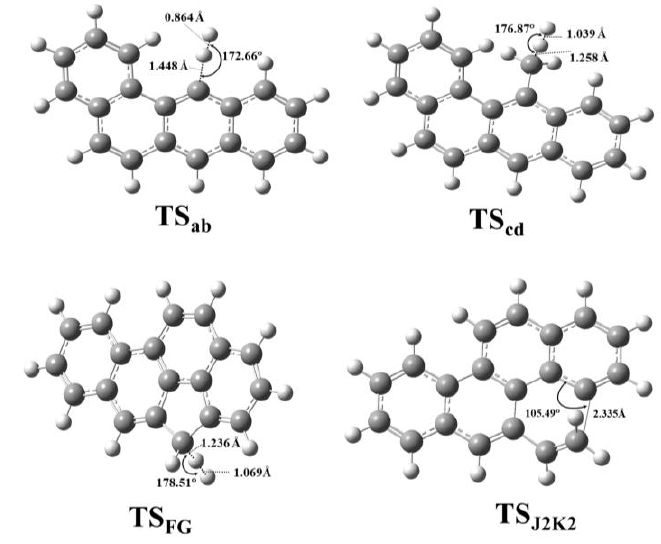
Figure 3. Representative transition state structures of benzo(a)pyrene formation starting from benzo(a)anthracene ( TS ab and TS cd ) and chrysene ( TS FG and TS J2K2 ) were located at the M06-2X/6-311++G(d,p) level of theory using a finetuned integration grid (99 radial shells and 974 angular points per shell) and depicted along with interatomic distances and bond angle.